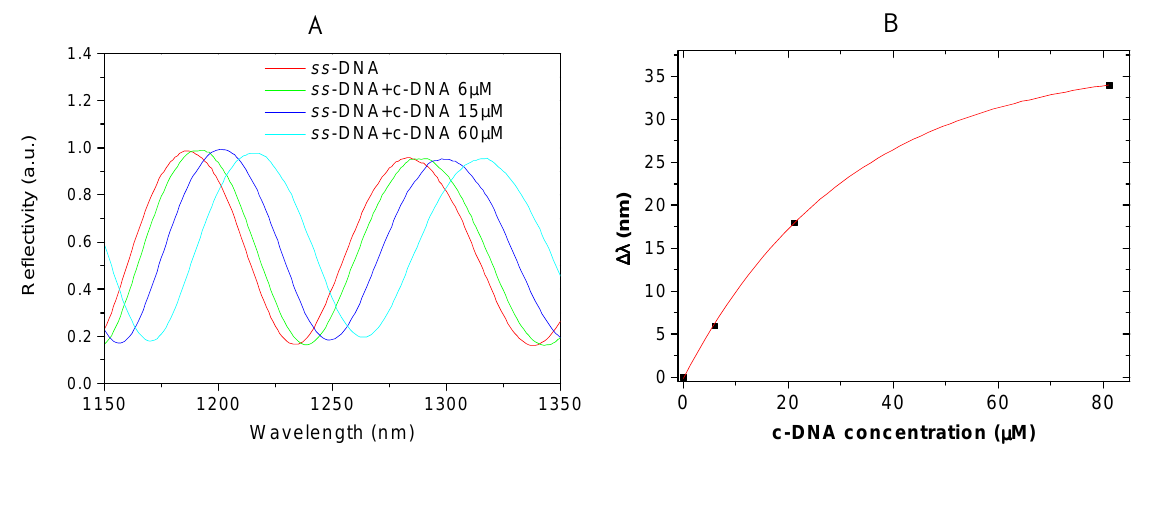
Figure 5. A) Fringes shifts due to ss DNA- c DNA interaction. B) Dose-response curve as a function of the cDNA